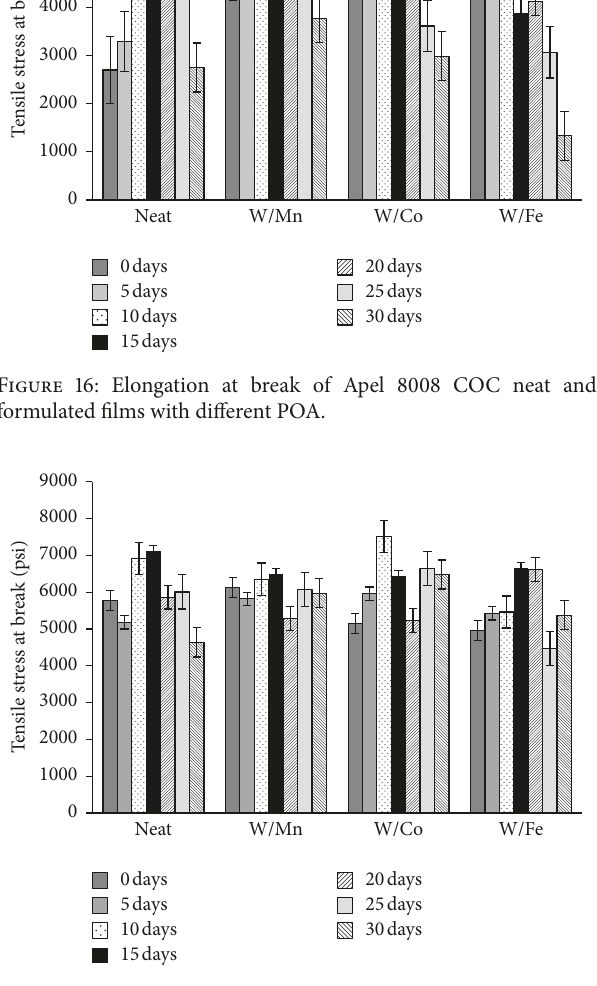
Figure 17: Tensile stress at break of Apel 8008 COC neat and formulated films with different